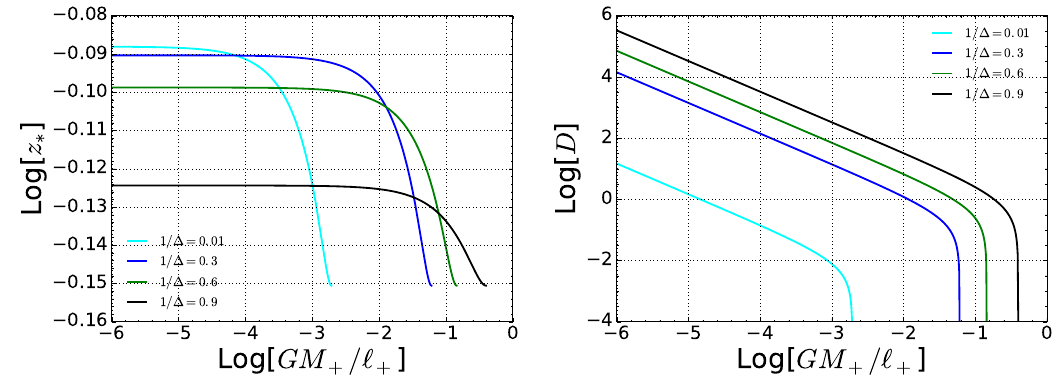
Figure 1 . Left: z ∗ in terms of GM + /ℓ + after solving eq. (2.16) for different values of ∆. Note that in general GM + /ℓ + < 1 except when ∆ 1. Right: parameter D in terms of GM + /ℓ + after ∼ solving eq. (2.17) for different values of ∆. We can see that there is a maximum mass cut-off.